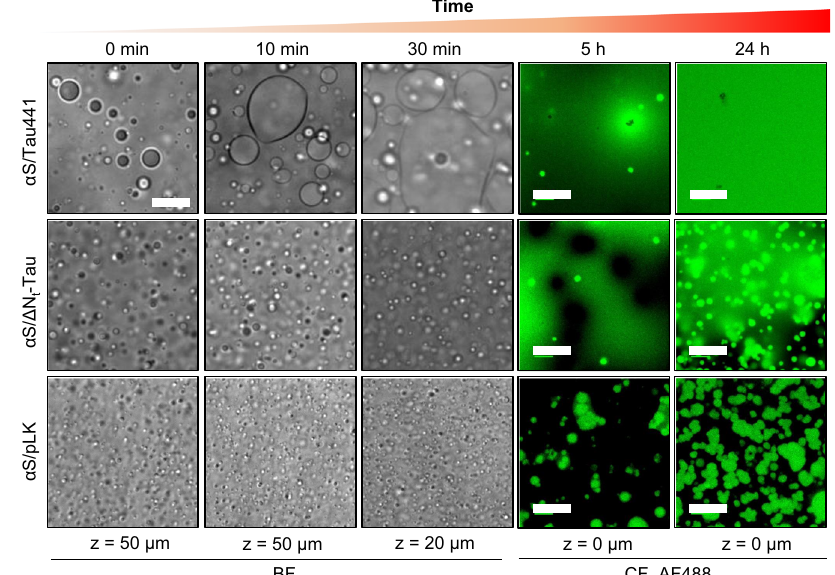
Δ N t -Tau (middle) or 1mM pLK (bottom) at different incubation times and focal heights ( z , distance from the bottom of the plate well). 4 – 6 experiments were repeated independently with similar results. α S/Tau441 coacervate wetting after 24h forms rafts larger than the image. Scale bar is 20 μ m for all